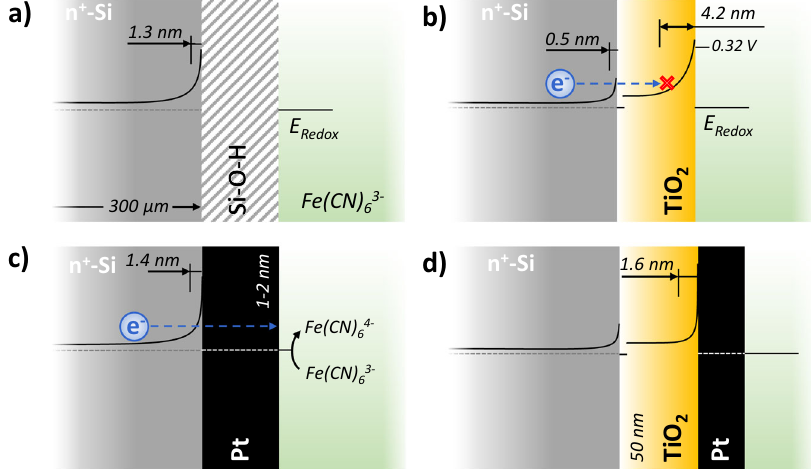
Fig. 2 Energy diagrams and charge transfer. Band alignments in the electrolyte for the bare c-Si electrode ( a ), TiO 2 ( b ), Pt ( c ), and Pt/TiO 2 ( d ). Note that barrier heights are marked with respect to the redox potential.